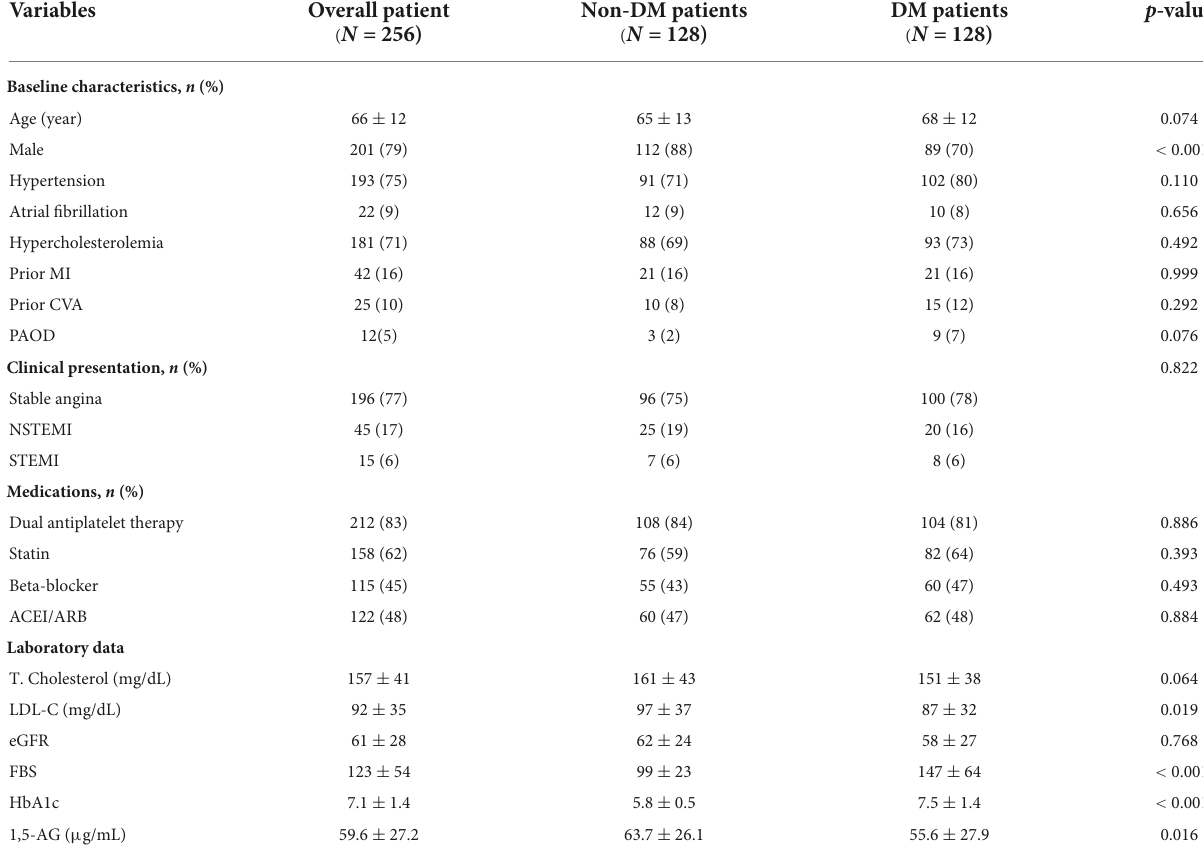
TABLE 1 Baseline characteristics of enrolled patients stratified by